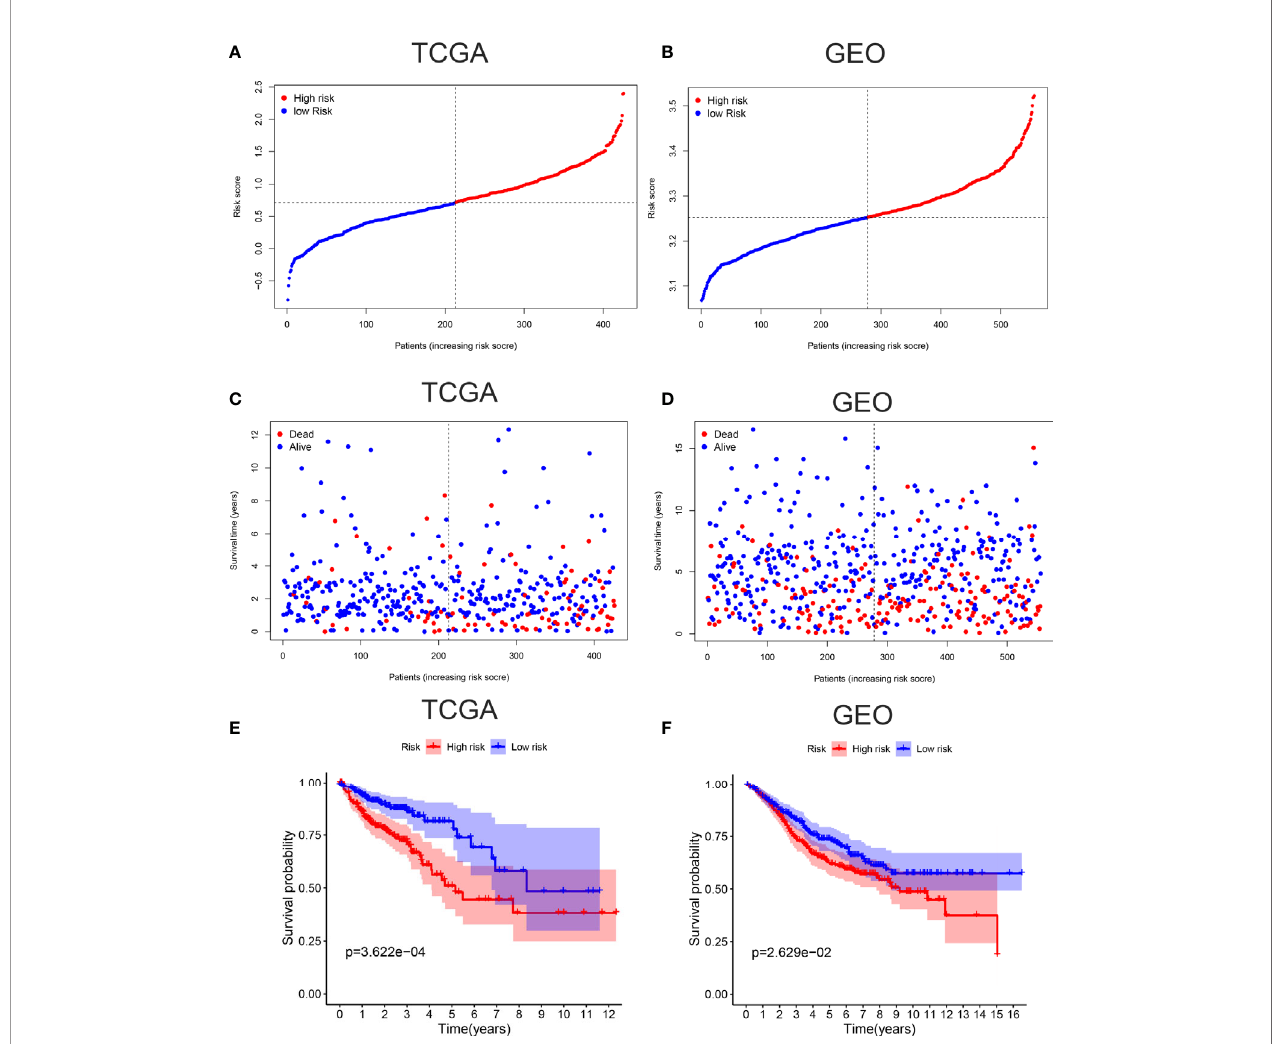
FIGURE 2 | Veri fi cation of accuracy of ferroptosis related gene signature in colon cancer. (A) The patients from TCGA cohort are divided into high-risk group and low-risk group based on the riskscore median values. (B) The patients from GEO cohort are divided into high-risk group and low-risk group based on its own riskscore median values. (C) The distribution of survival time in the high-risk group and low-risk group in the TCGA cohort. (D) The distribution of survival time in the high-risk group and low-risk group in the GEO cohort. (E) Kaplan-Meier curves showed the survival differences between high-risk group and low-risk group using the log-rank test in the TCGA cohort. (F) Kaplan-Meier curves showed the survival differences between high-risk group and low-risk group using the log-rank test in the GEO